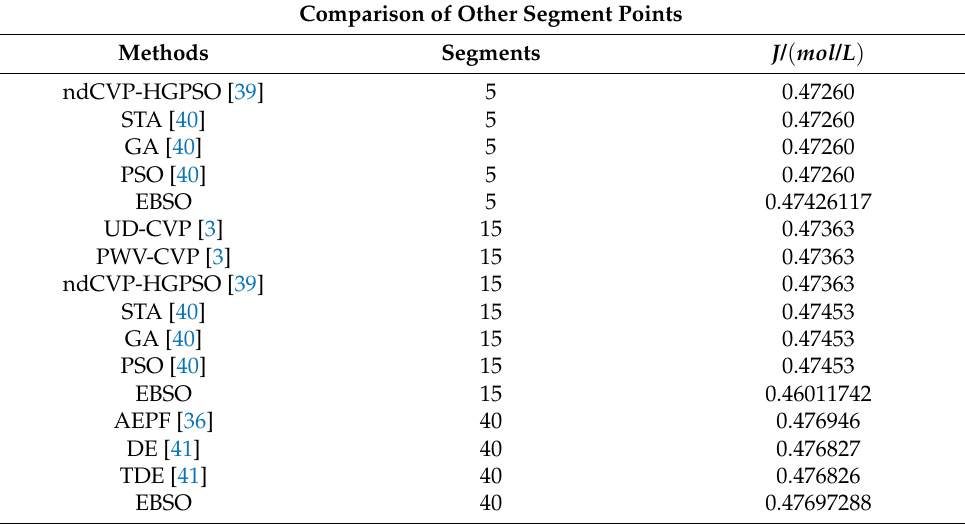
Figure 31. Optimal trajectory of state variables ( N = 20). The comparison of other segment points and the algorithm comparison results of different segment numbers are shown in Table 10. Table 10. Comparison of methods of tubular reactor.